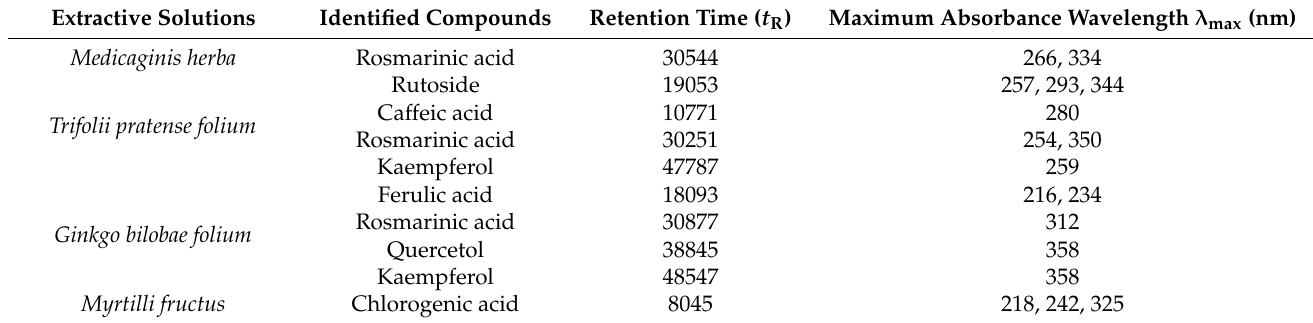
Table 5. Bioactive compounds separated from and identified in the Medicaginis herba, Trifolii pratense flores, Ginkgo bilobae folium, and Myrtilli fructus hydroalcoholic extractive